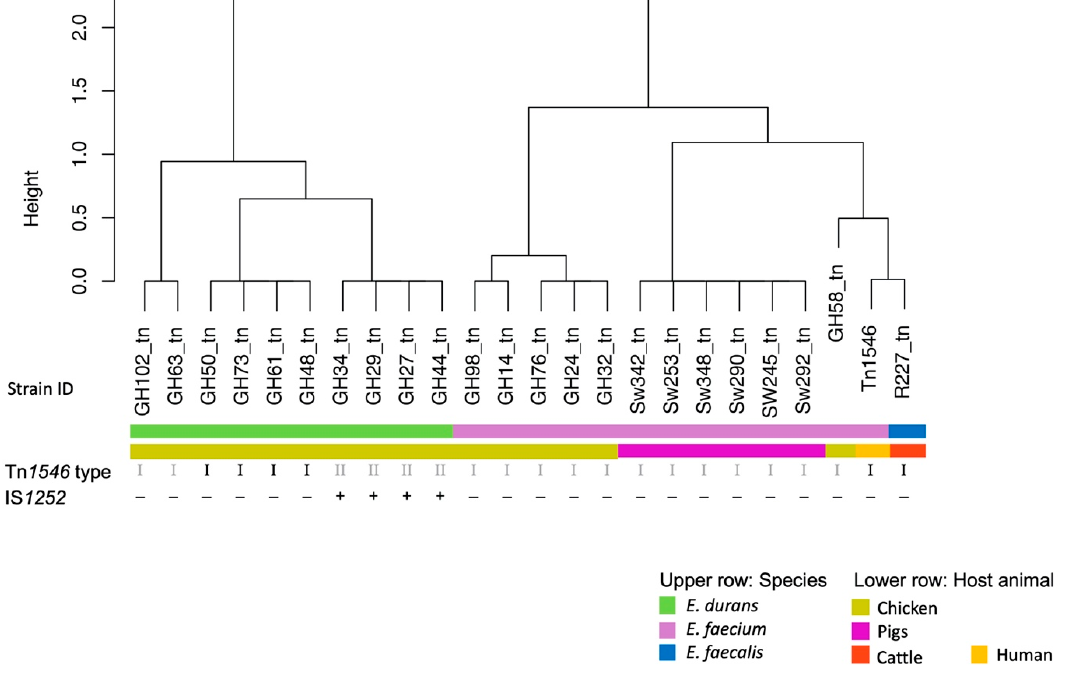
Figure 2. Linear maps of vanA encoding regions of the prototype Tn 1546 (GenBank M97297) from human E. faecium B4147 [35], and of vancomycin-resistant enterococci from healthy food-producing animals. aadK , aminoglycoside 6- adenylyltransferase; merA , mercury resistance gene; *, putative open reading frames.